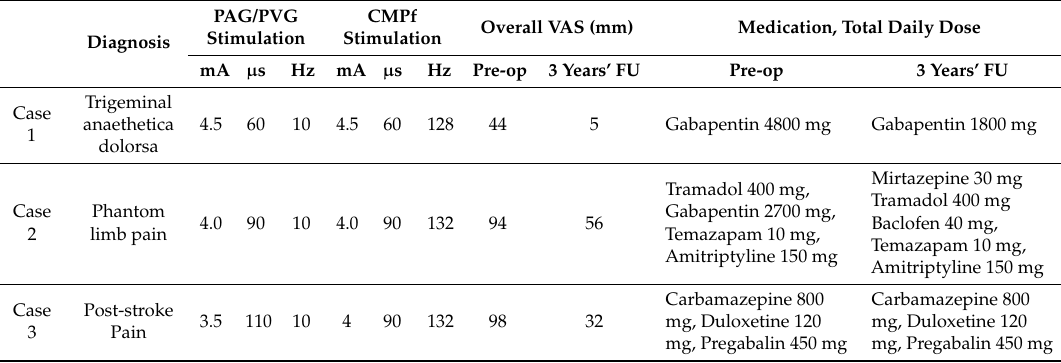
Table 1. Stimulation parameters and overall Visual Analogue Scales (VAS) at pre-operative assessment and 3 years’ follow-up (FU) in single electrode dual targeting of the Periaqueductal grey/Periventricular grey (PAG/PVG) and Centromedian Intralaminar Parafasciular complex (CMPf) for three patients with chronic pain